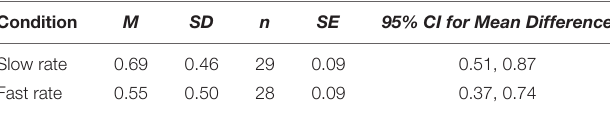
TABLE 3 | Descriptive statistics of mean correct score in two conditions of exposure. Experiment 2.